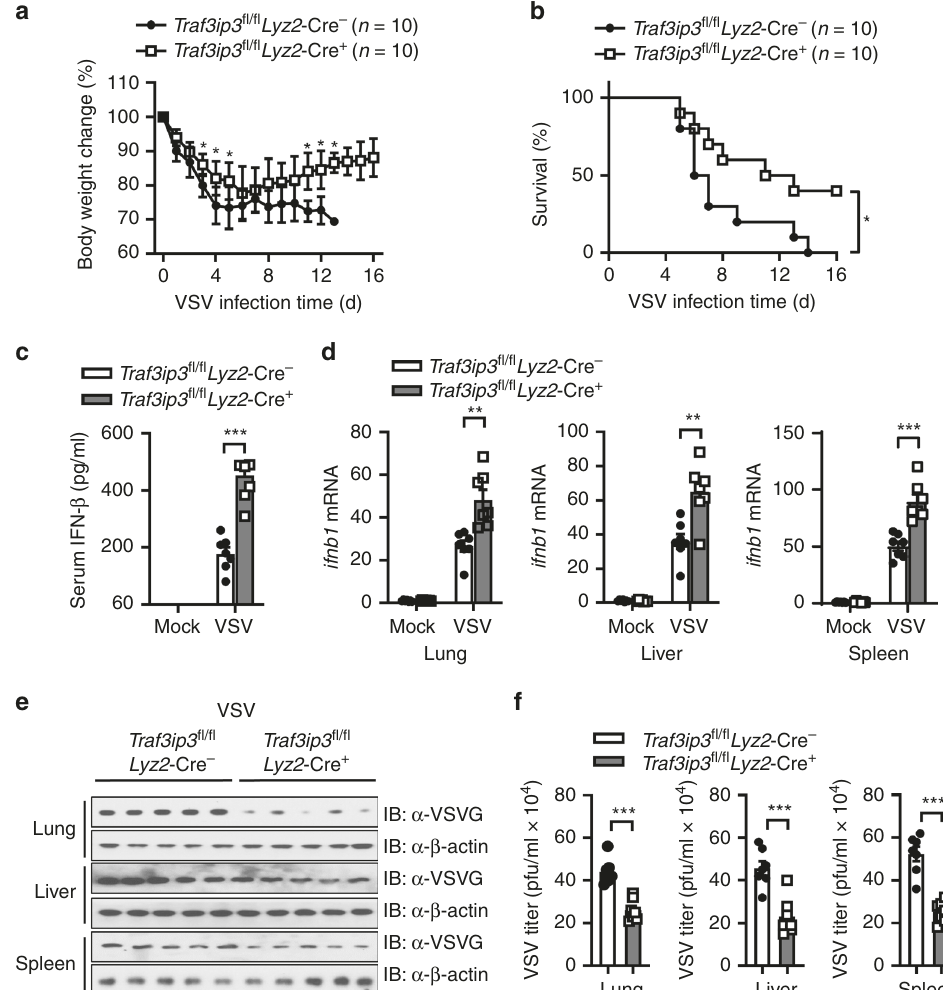
Fig. 7 Traf3ip3 de fi cient mice are resistant to VSV infection. a , b Body weight change and survival rate of Traf3ip3 fl / fl Lyz2 -Cre − and Traf3ip3 fl / fl Lyz2 -Cre + mice infected with VSV (0.5 × 10 7 pfu per mouse) by i.p. injection. c ELISA of serum IFN- β from Traf3ip3 fl / fl Lyz2 -Cre − and Traf3ip3 fl / fl Lyz2 -Cre + mice